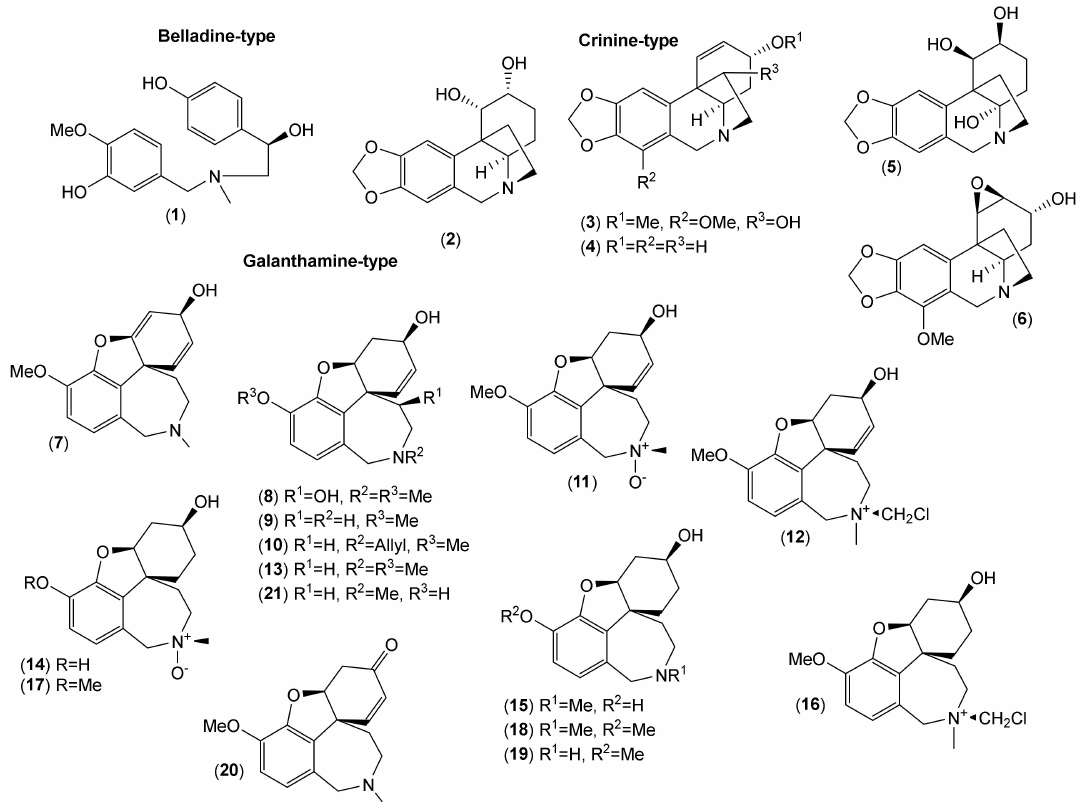
Figure 1. Amaryllidaceae alkaloids of belladine-, crinine-, and galanthamine-type reported in Lycoris species.